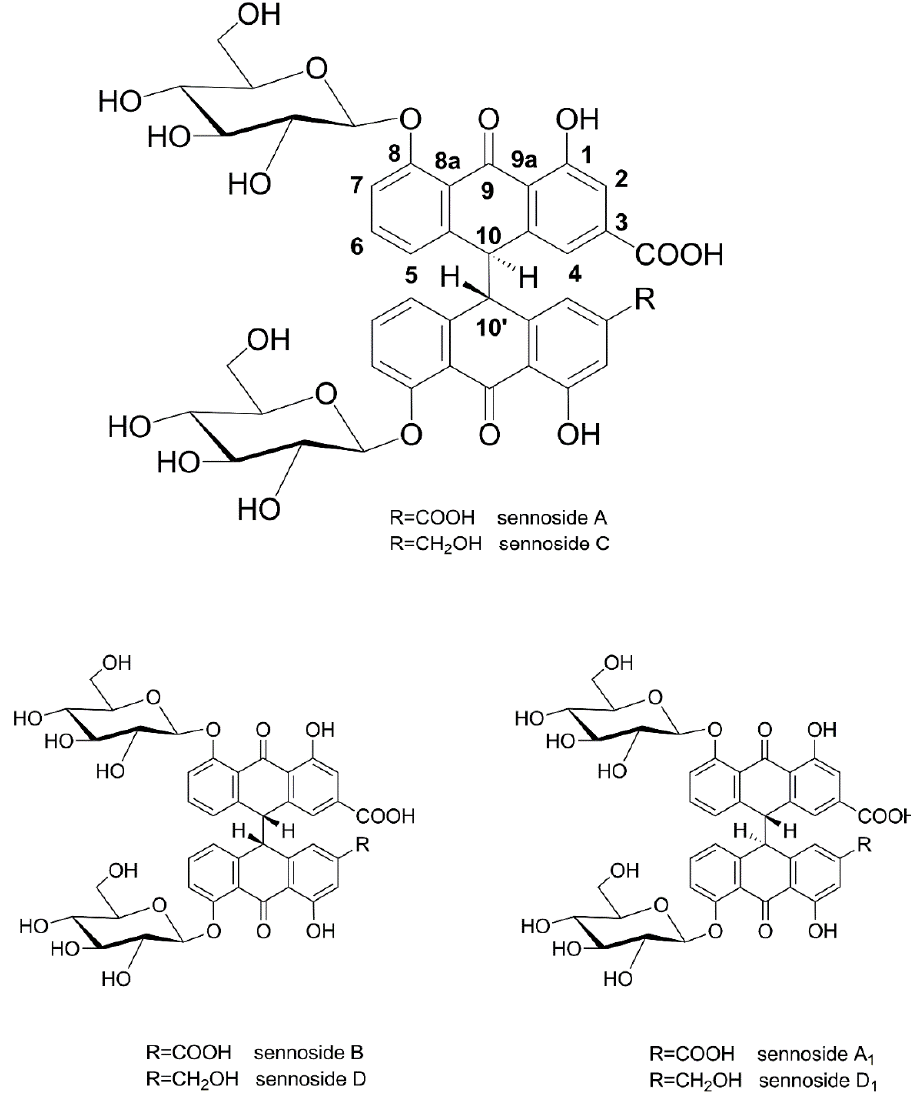
Figure 1. Chemical structures of sennosides A, B, C, D, A 1 , and D 1 .